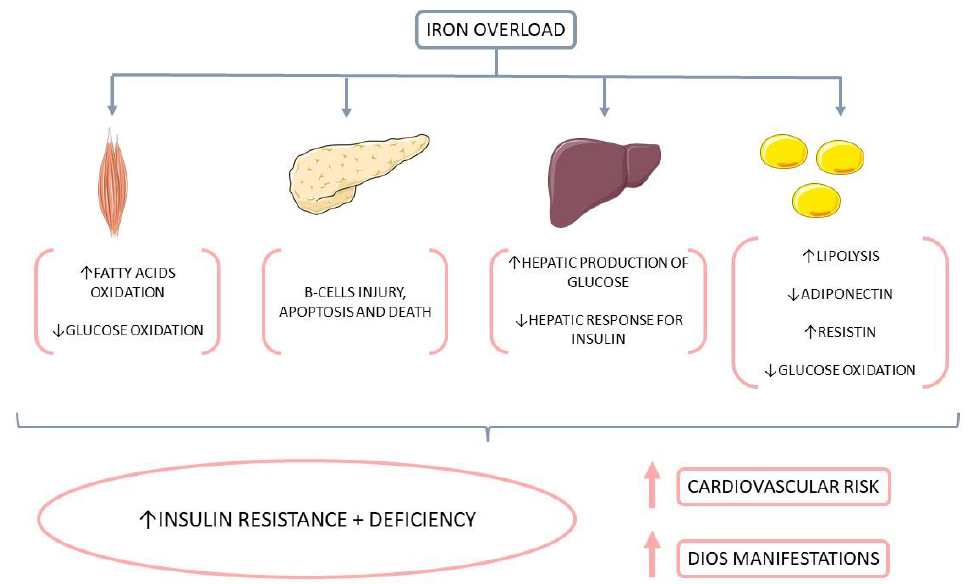
Figure 5. Consequences of iron overload in β -cell, muscle, and adipocyte. Iron overload is related to a decrease in insulin release in β -cells. In muscle, it is associated with decreased glucose disposal and an increase in the oxidation of free fat acids (FFA). In adipocytes, there is a reduction in glucose uptake. This scenario contributes to insulin resistance (IR), diabetes mellitus (DM), and cardiovascular diseases (CVD). ↑ : increase, ↓ : decrease.